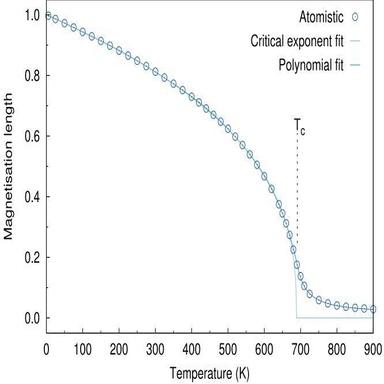
Comparison of the fittings of the magnetisation achieved for a 5 nm grain via the two available methods implemented in MARS. The dots represent the atomistic data, while the lines show the fits.